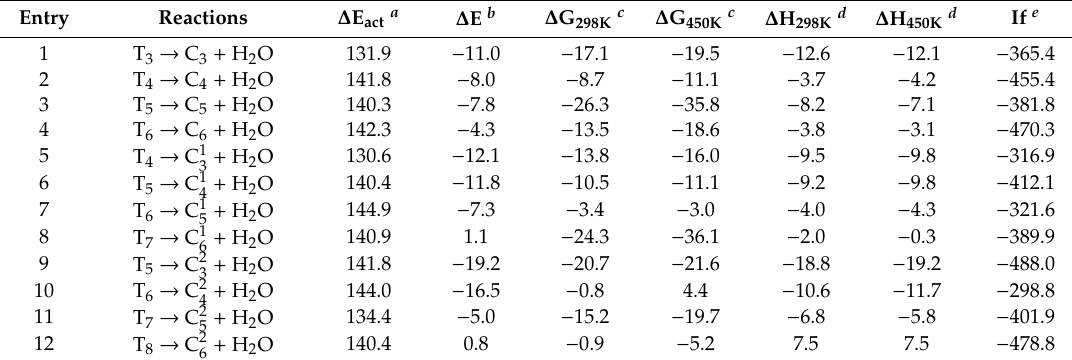
Table 2. Energy profile (kJ / mol) for the formation of cyclic oligomers through the AAM mechanism. Entry